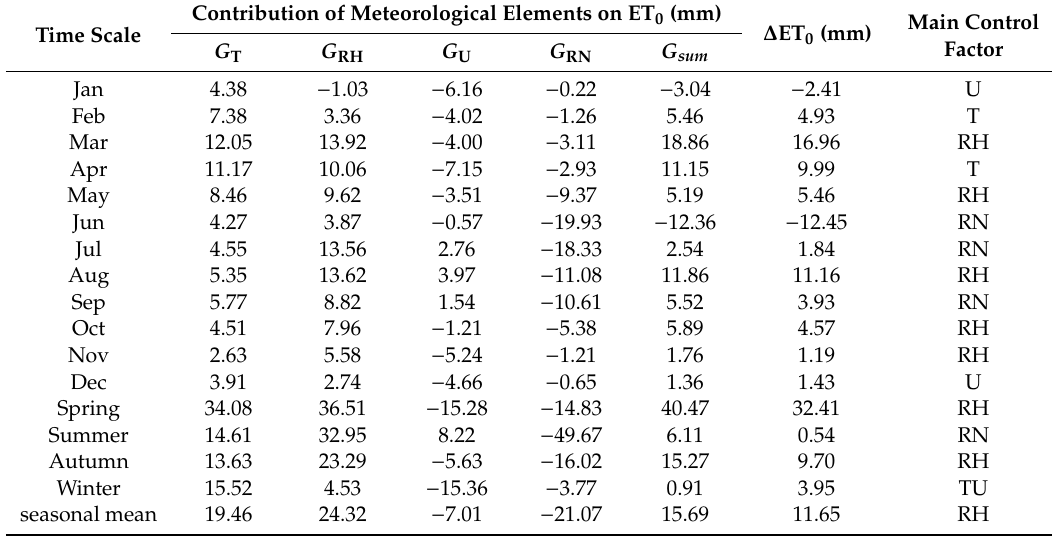
Table 2. Contributions of the four meteorological factors to reference evapotranspiration (ET 0 ) on monthly and seasonal